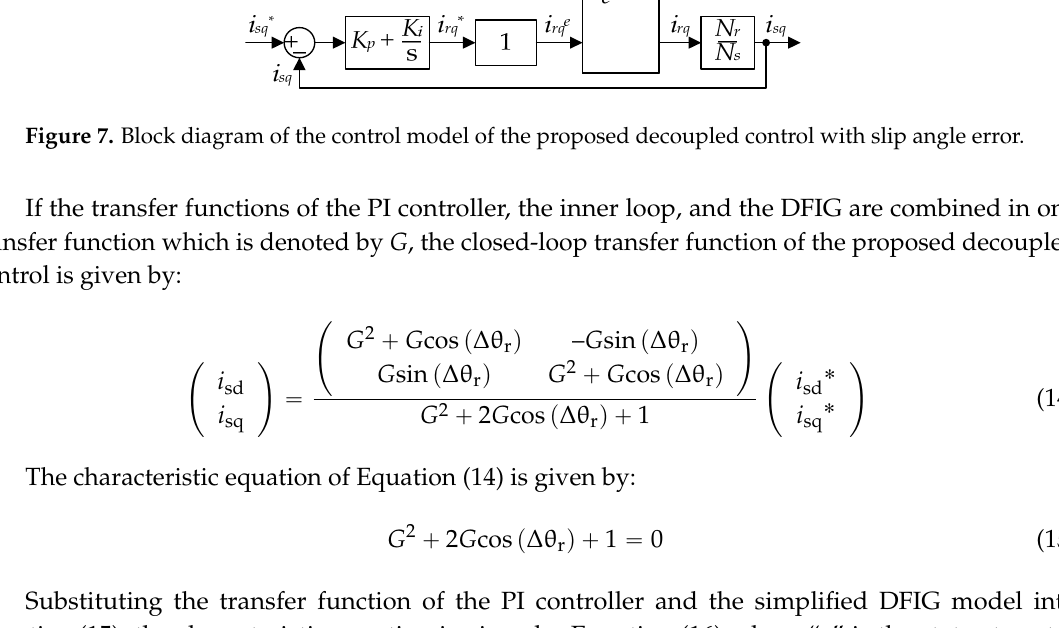
Figure 7. Block diagram of the control model of the proposed decoupled control with slip angle error.